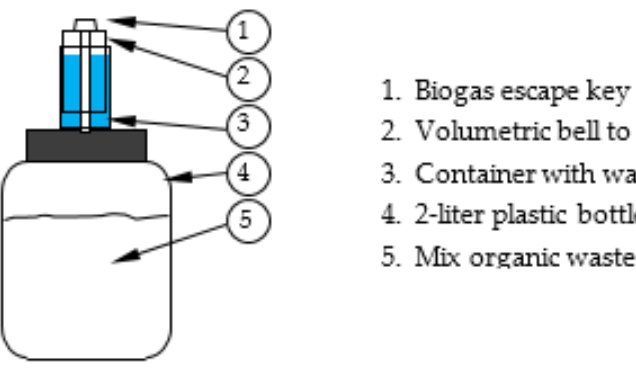
Figure 3. Biodigester installed [11].